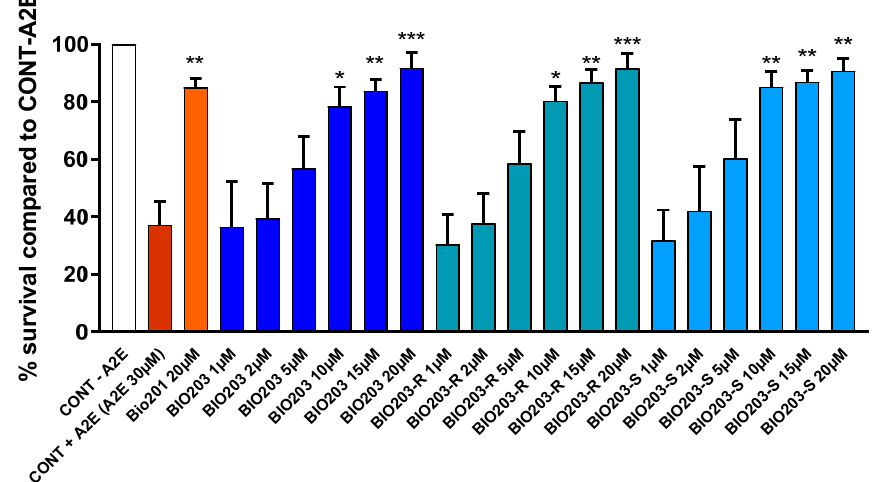
Figure 2. Dose-response of the photoprotection induced by BIO201, BIO203 (racemate), and its enantiomers R and S on RPE cells cultivated in the presence of A2E and blue-light exposure. A2E was used at 30 µ M and BIO203 and its enantiomers at the concentrations indicated. Bars represent mean ± s.e.m. with n = 3 per group. * p < 0.05, ** p < 0.01, *** p < 0.001, compared to CONT + A2E (One-way ANOVA, Dunnett’s post-test).